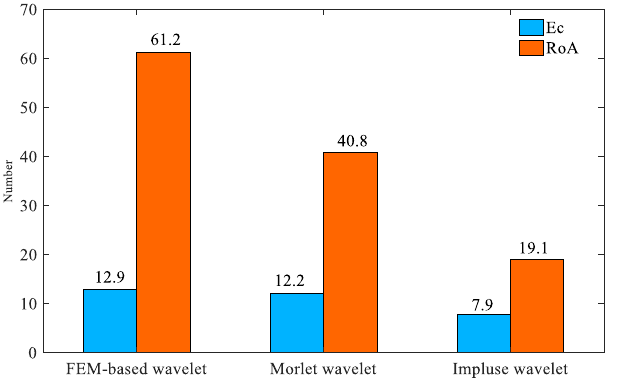
Figure 14. The E c s and RoA s of the filtered signals by three wavelet bases for inner ring fault.